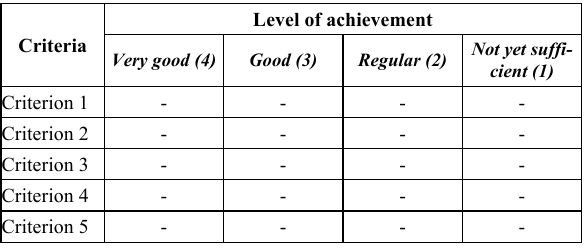
TABLE I. S CORES FOR CRITERION